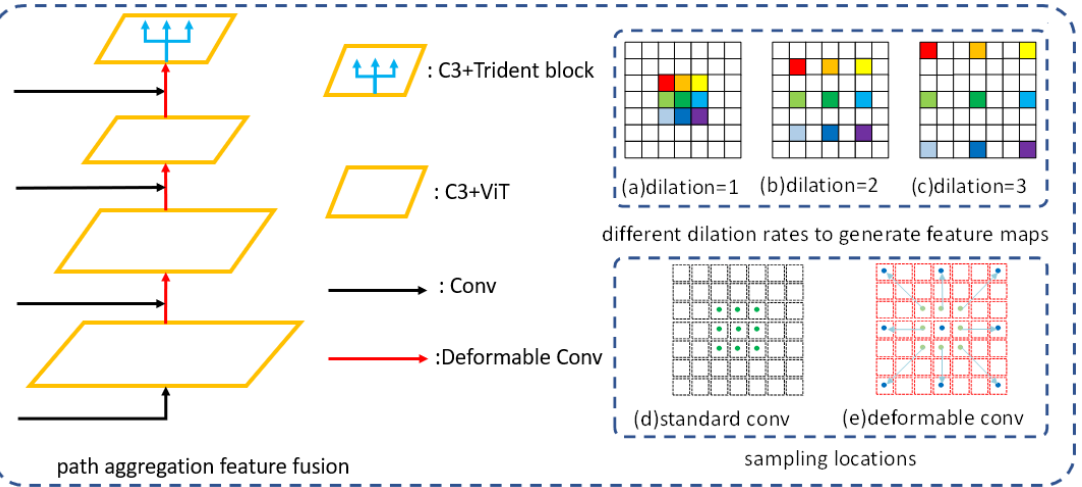
Figure 8. Overall structure of the proposed target detection model: ( a – c ) Feature maps generated by trident block with different dilation rates. ( d , e ) Sampling locations of standard convolution and deformable convolution.